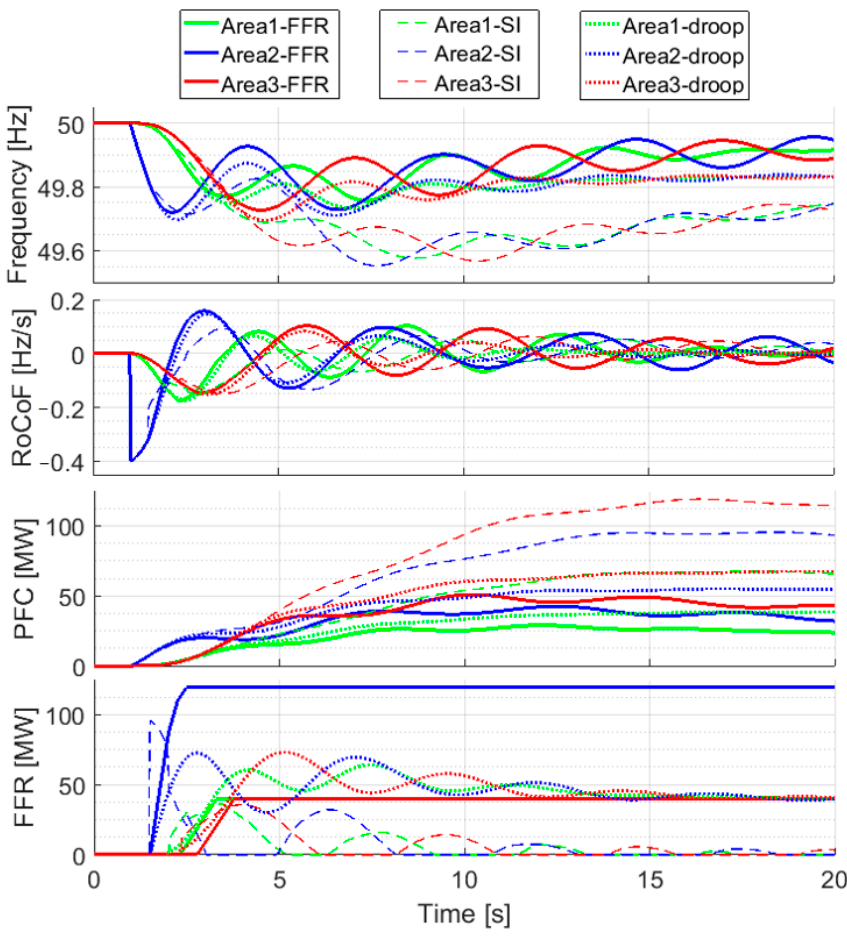
Figure 14. Three-area test system response in the case of a disturbance in Area2—Weak grid—Case 1.2.